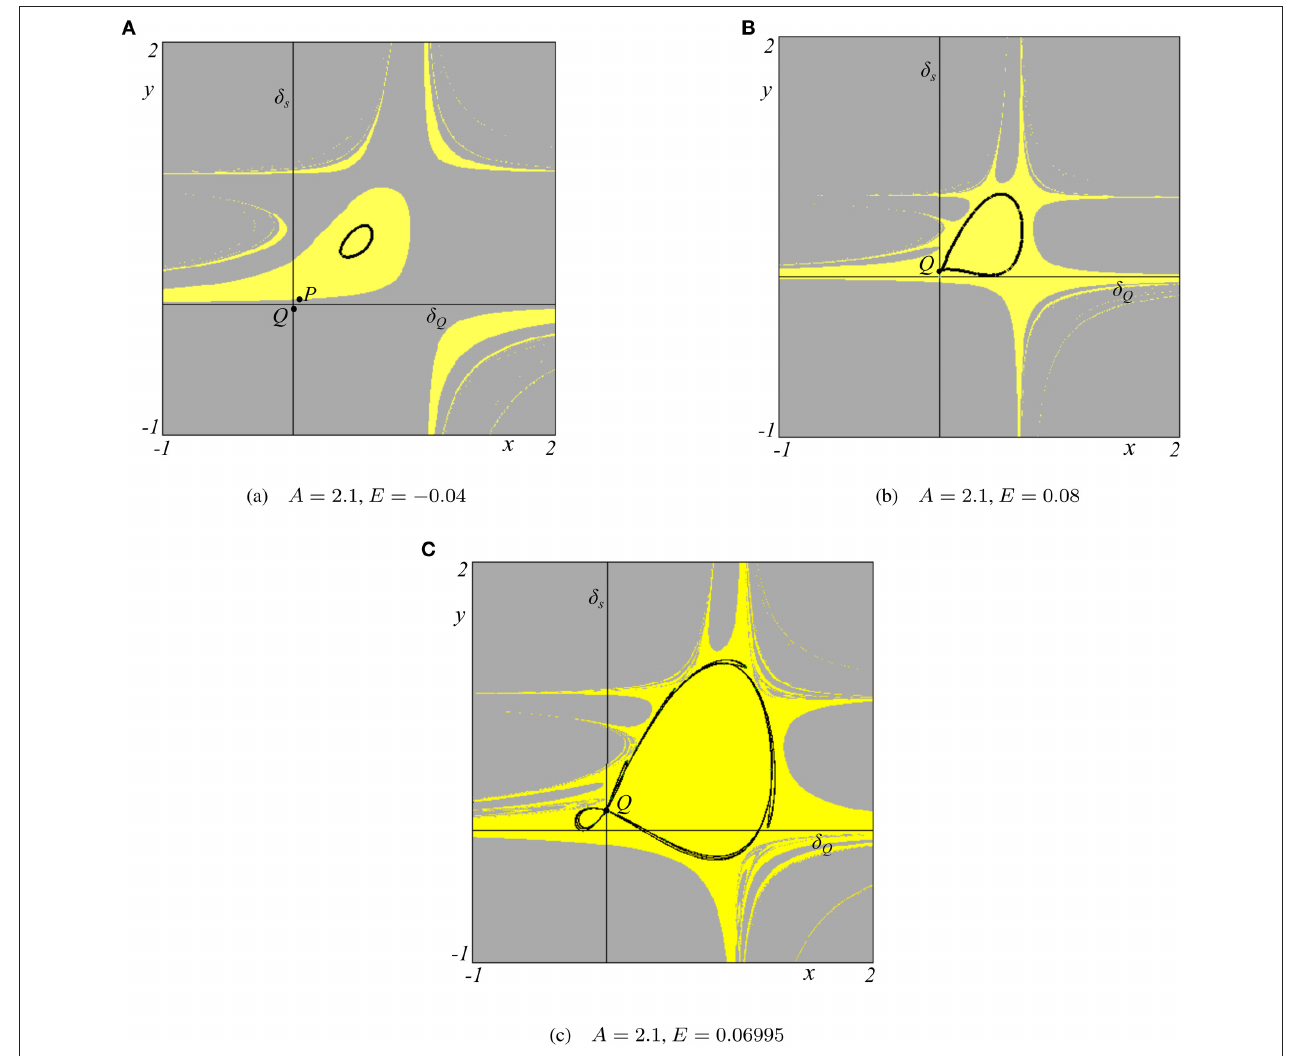
FIGURE 9 | Basin of attraction (yellow color) and attractors for the model with external interference. The gray region represents the basin of unfeasible trajectories, namely all trajectories starting from the region converge to infinity. Point Q represents the focal point while P is the fixed point of the map. In (A) the basin of attraction of a closed invariant curve is represented. In (B) the invariant closed curve contacts tangentially with the prefocal line of the inverse M − 1 and in (C) the chaotic attractor is characterized by a knot of infinitely many curves that shrink into the focal point Q